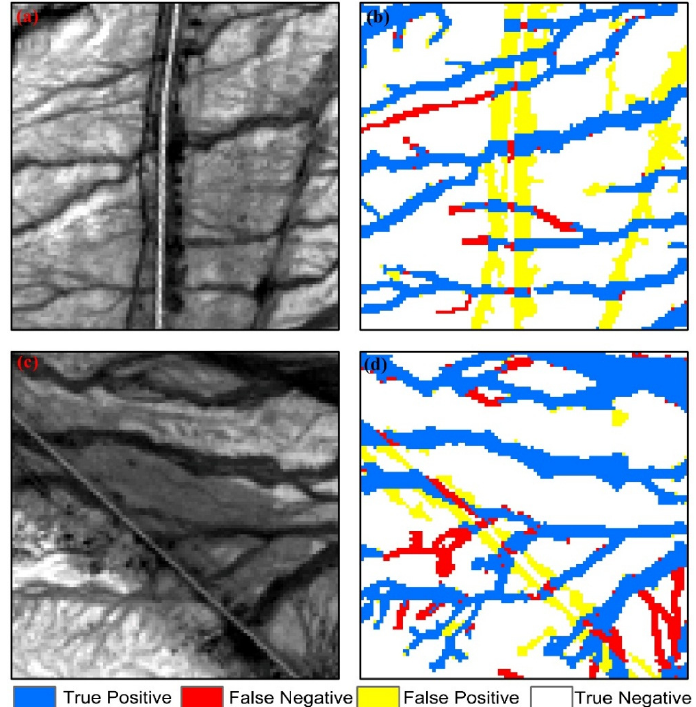
Figure 13. NWI images and over-extractions around roads (two parallel false wadis on both sides). ( a,b ) are the reference map and the extraction result for a local block; ( c,d ) are the reference map and the extraction map for another local block.